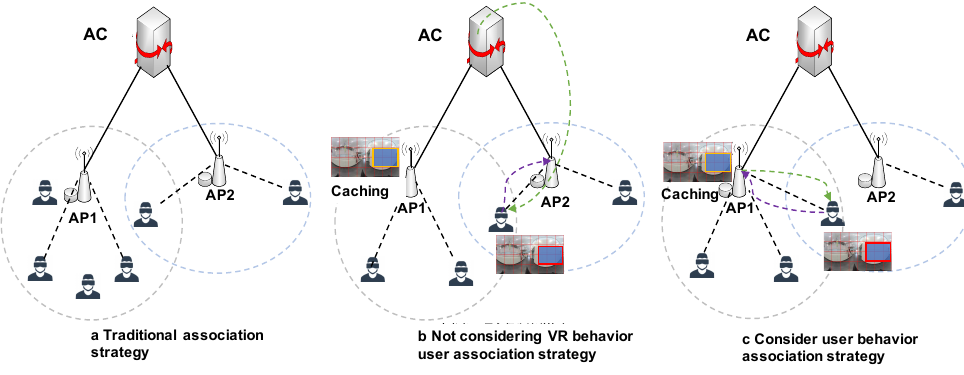
Figure 3. Impact of VR on user and AP